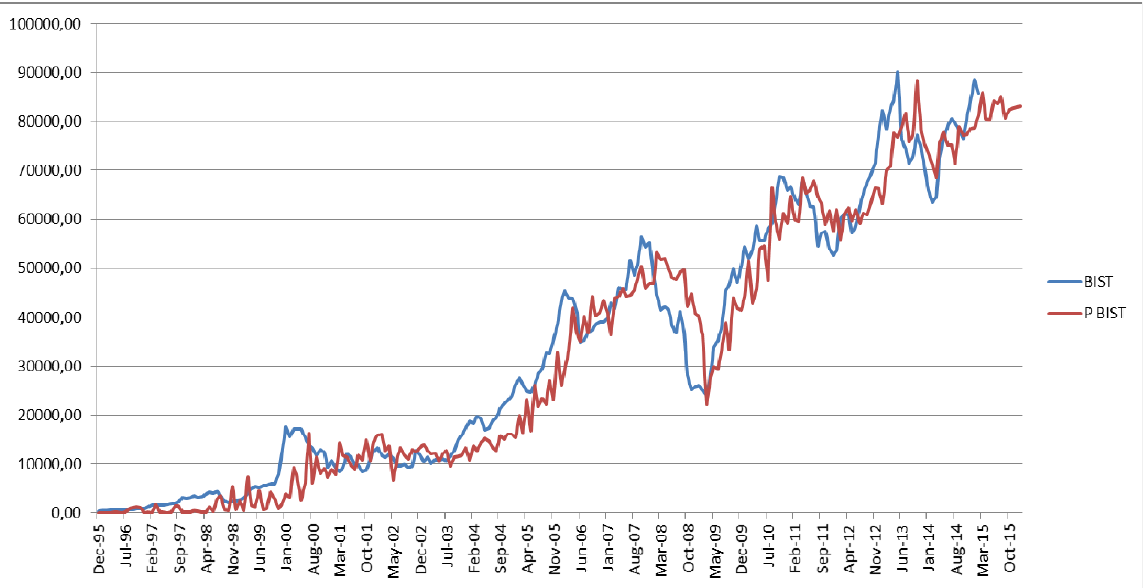
Figure 3. The Comparison between the actual values (USD) and the predicted values (P USD) obtained by the second ANN model.